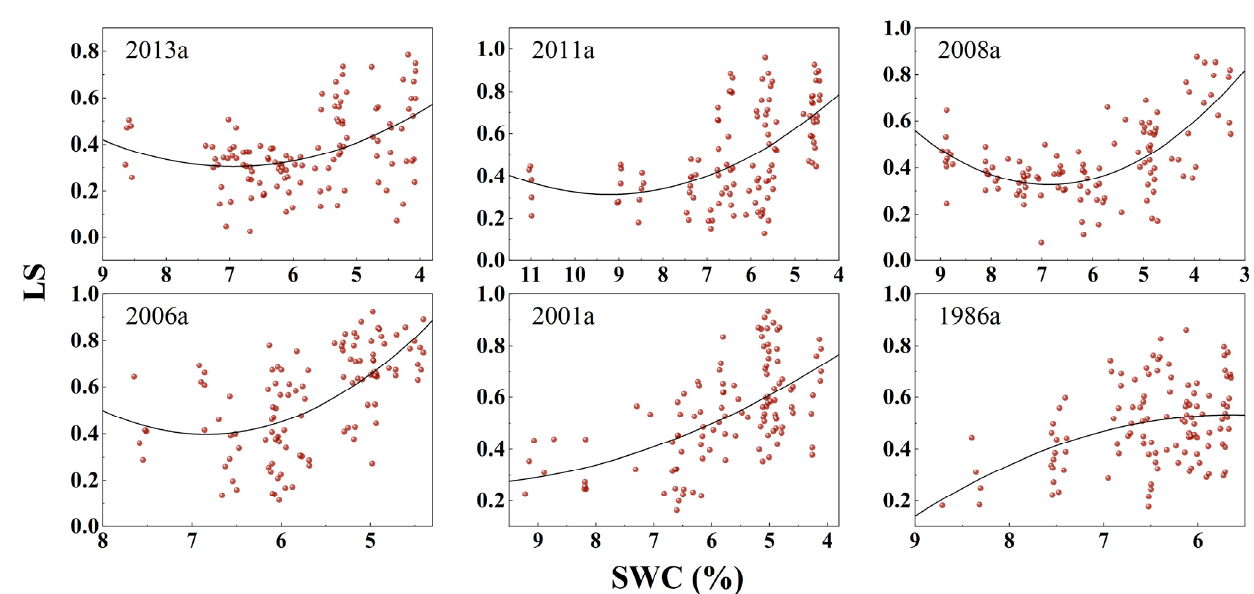
Figure 8. Fi tt ing curve between Ls value and SWC. Figure 8. Fitting curve between Ls value and